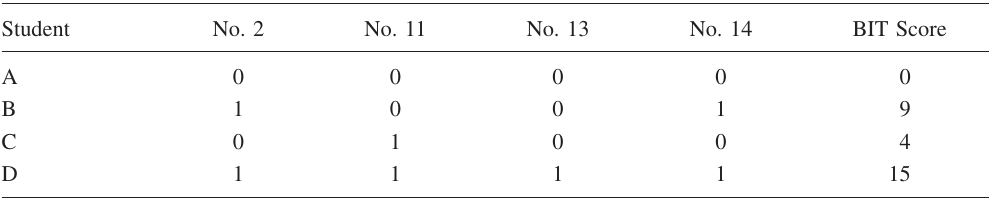
TABLE I. Example of the BIT scoring method used to immediately show which questions the students answered correctly and incorrectly on the FCI N3 questions.